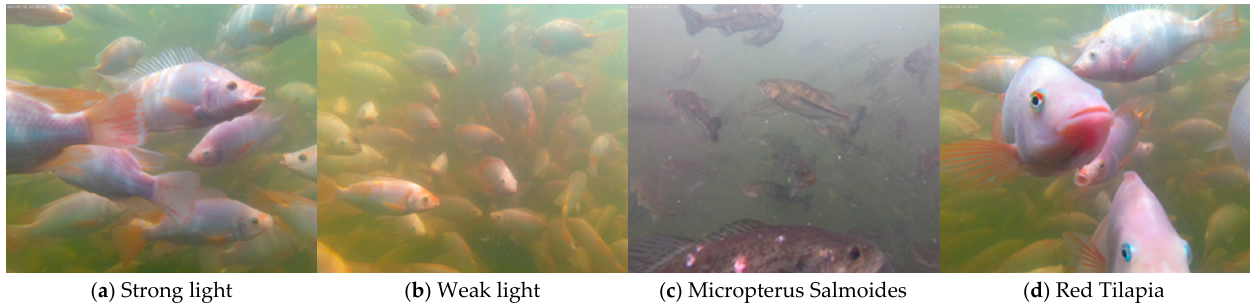
Figure 2. Example images in the underwater environment.